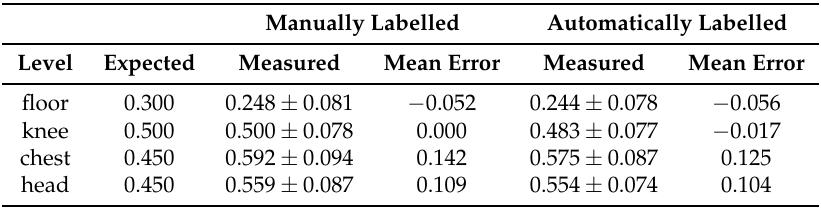
Table 7. The horizontal distance between the participant and the object was estimated at the beginning and ending of every lift. Error is calculated as h est − h actual , where h est is the estimated horizontal distance and h actual is the reference horizontal distance. Distances are displayed in meters.